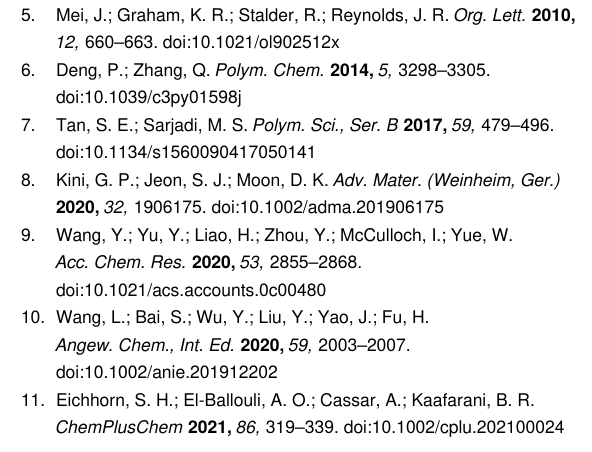
make it possible to conclude that the design of these com- pounds is promising for mass spectrometry, for catalysts for hydrogen production, and for photothermal cancer